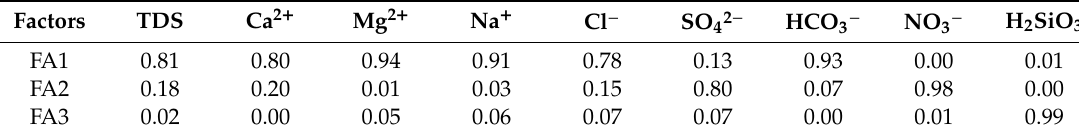
Table 5. The percent of variance in a given hydrogeochemical parameter accounted for by each factor.